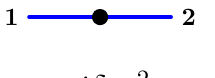
Figure 6. Diagrammatic representation of the one loop counter-term for m 2